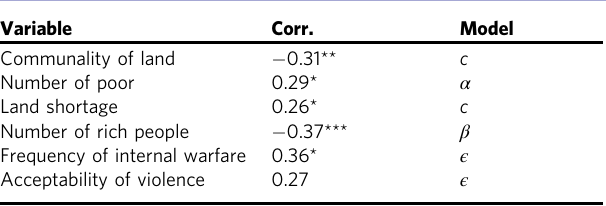
The correlated variables, their correlation, and the corresponding parameters in our model are presented. Here, we list the variables relevant to the model. The three variables above the dashed line are correlated with the parent – child relationship, and those below the dashed line are correlated with the inter-sibling relationship. See Supplementary Tables for the list